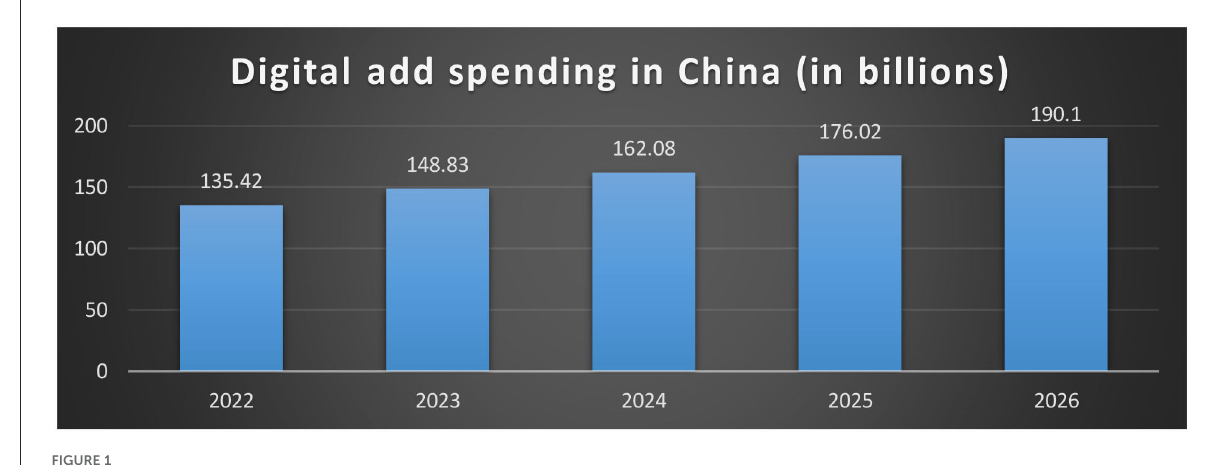
FIGURE1 Digital advertisement spending in